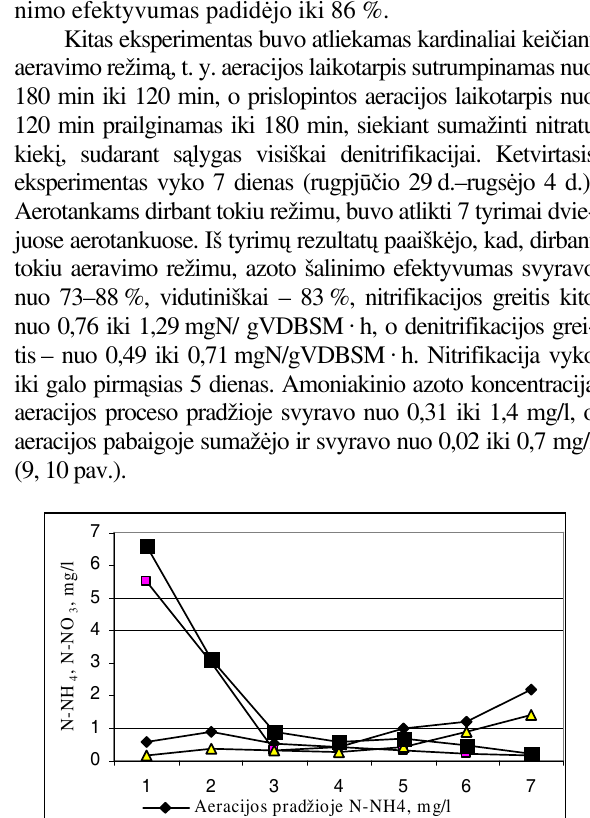
Fig 7. Concentration change of ammonium nitrogen and nitrates in the first aeration tank in the beginning and at the end of aeration at aeration rate of 180, 120 min, and reduced aeration rate of 120 min